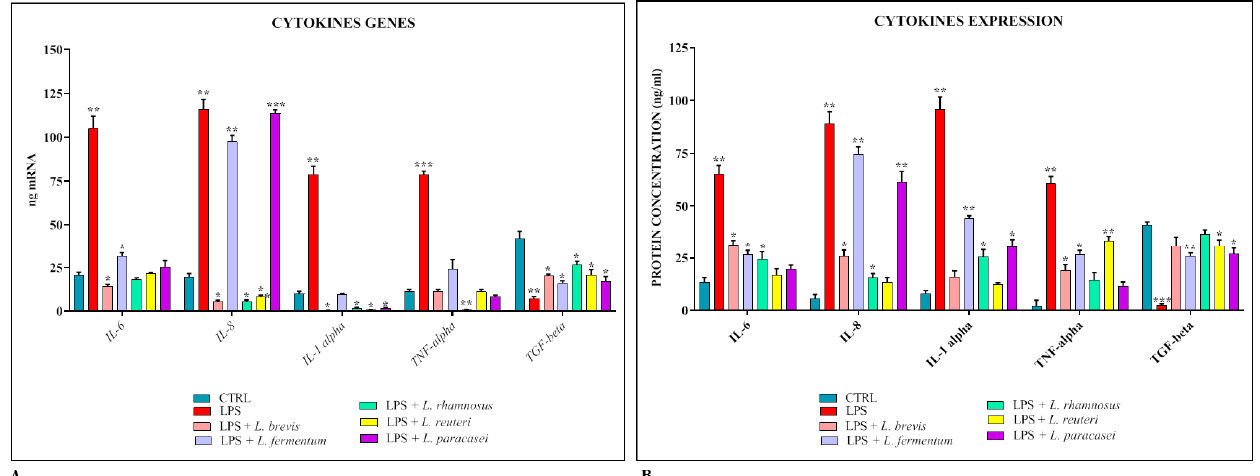
Figure 3. Comparison between relative gene expression ( A ) and protein concentration ( B ) in Caco-2-HT29-MTX co-cultures treated with LPS of S. Typhimurium with or without Lactobacillus spp. The data are representative of three different experiments ± SD. Significant differences are indicated by * p < 0.05, ** p < 0.01, *** p <